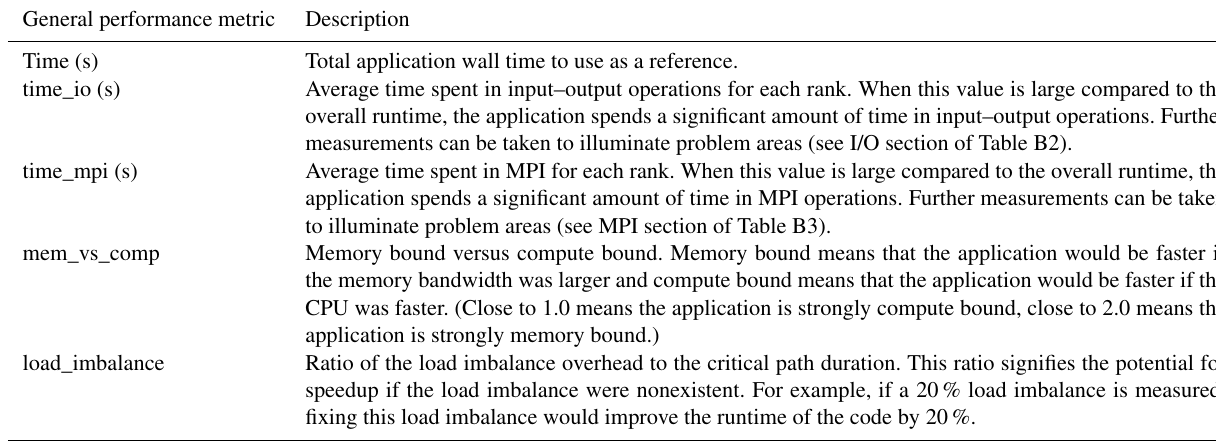
Table B1. Description of general performance analysis metrics currently supported by our RCF.